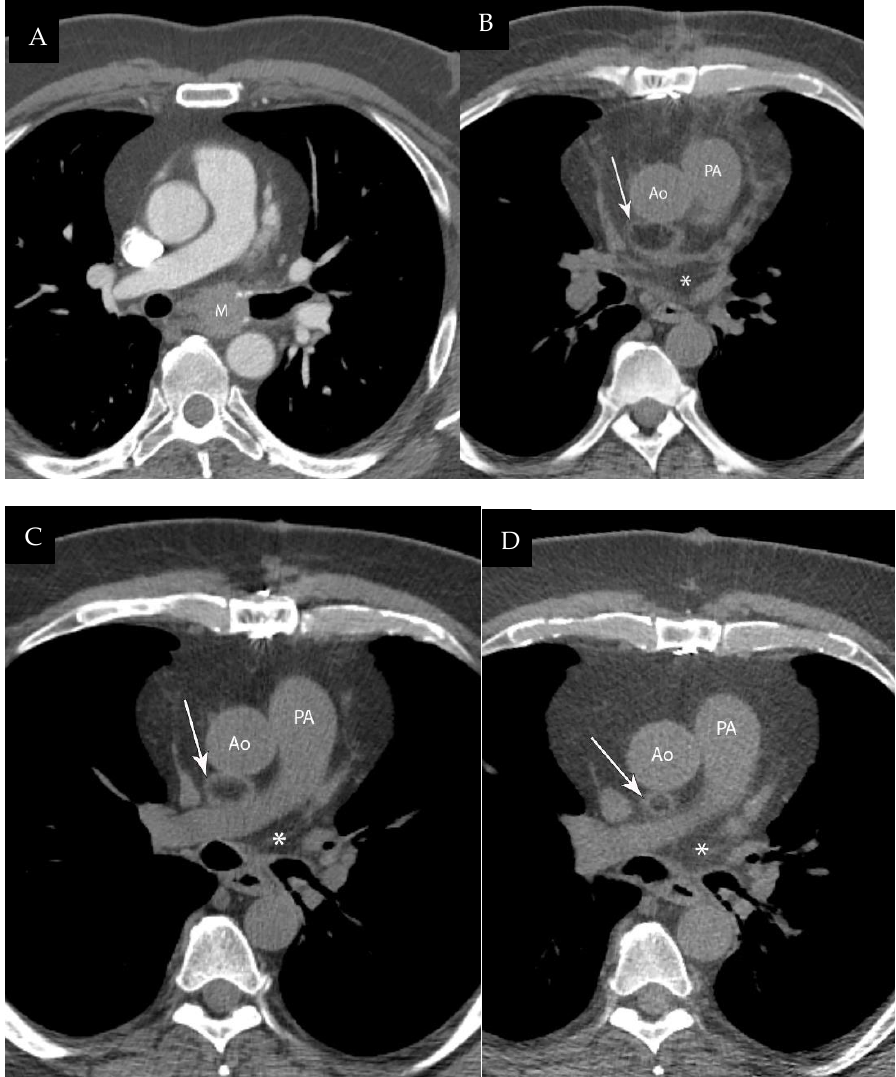
Figure 12. Epi-pericardial fat necrosis following surgery. 57 year-old man. ( A ). Contrast enhanced CT shows the mucoepidermoid carcinoma (M) in the left main bronchus. The patient underwent median sternotomy to resect the tumor. ( B ). CT 4 months following surgery shows fat necrosis with typical fat and soft tissue core with a capsule in the superior aortic recess of the pericardial space (arrow) posterior to the aorta (Ao). PA= pulmonary artery. Note the fat in the oblique sinus of the pericardial space (asterisk). ( C ). CT 6 months and ( D ) CT 2 years later show the fat necrosis (arrow) regresses over time. Although patients with epi-pericardial fat necrosis can present with chest pain, this patient was asymptomatic. Reprinted from Shroff, G.S et al. Pitfalls in oncologic imaging of the pericardium on CT and PET/CT [4].